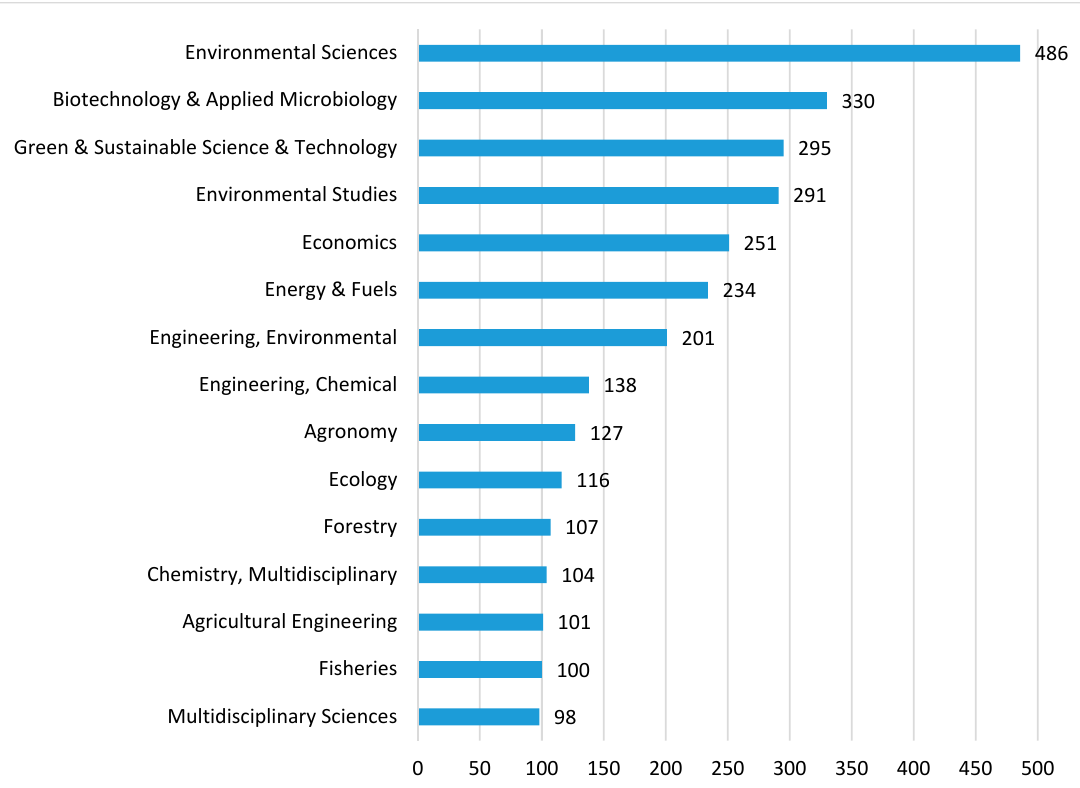
Figure 3. Number of articles per research area ( n = 2489).